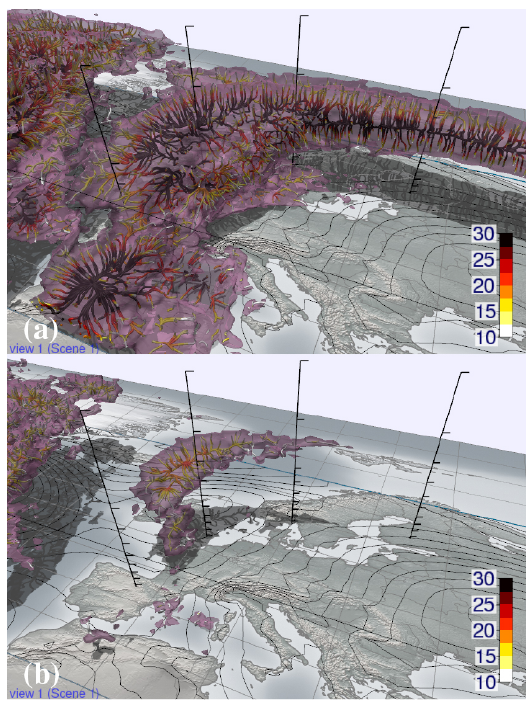
Figure 14. Adjusting the filter criterion for the p( WCB ) forecast shown in Fig. 12c (forecast from 00:00UTC, 15 October 2012, valid at 18:00UTC, 19 October 2012). Filter criterion of (a) 400hPa and (b) 550hPa in 48h (in Fig. 12c a criterion of 500hPa in 48h is used). The purple transparent isosurfaces show a probability of 10%. Normal curves inside the isosurfaces are coloured by proba- bility (%). Black contour lines show ensemble mean sea level pres-